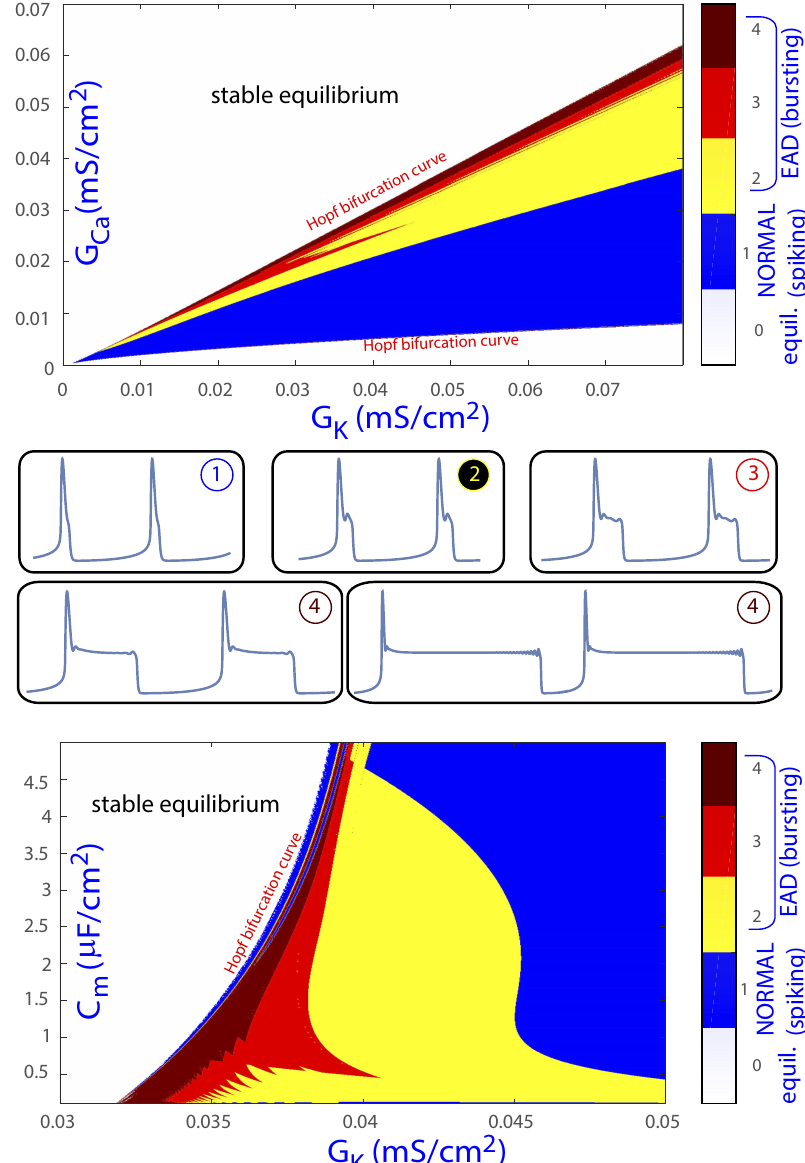
Figure 9. Classification of the different dynamical behaviors of the orbits on the parametric planes ( G K , G Ca ) and ( G K , C m